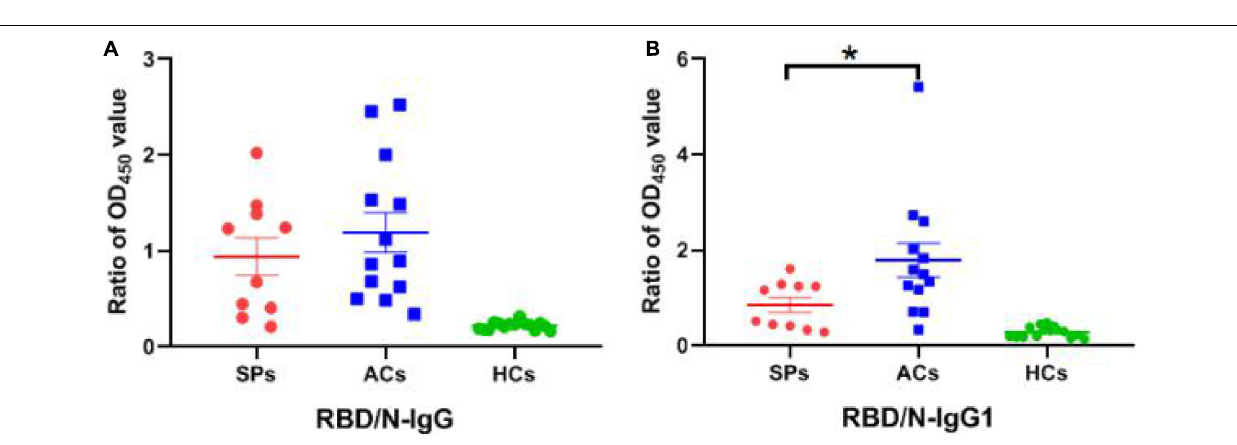
FIGURE 6 | The ratio of OD 450 value between RBD-specific and N-specific IgG and IgG1 in SPs, ACs, and HCs. (A) The ratio of OD 450 value between RBD-specific IgG and N-specific IgG. (B) The ratio of OD 450 value between RBD-specific IgG1 and N-specific IgG1. * P <